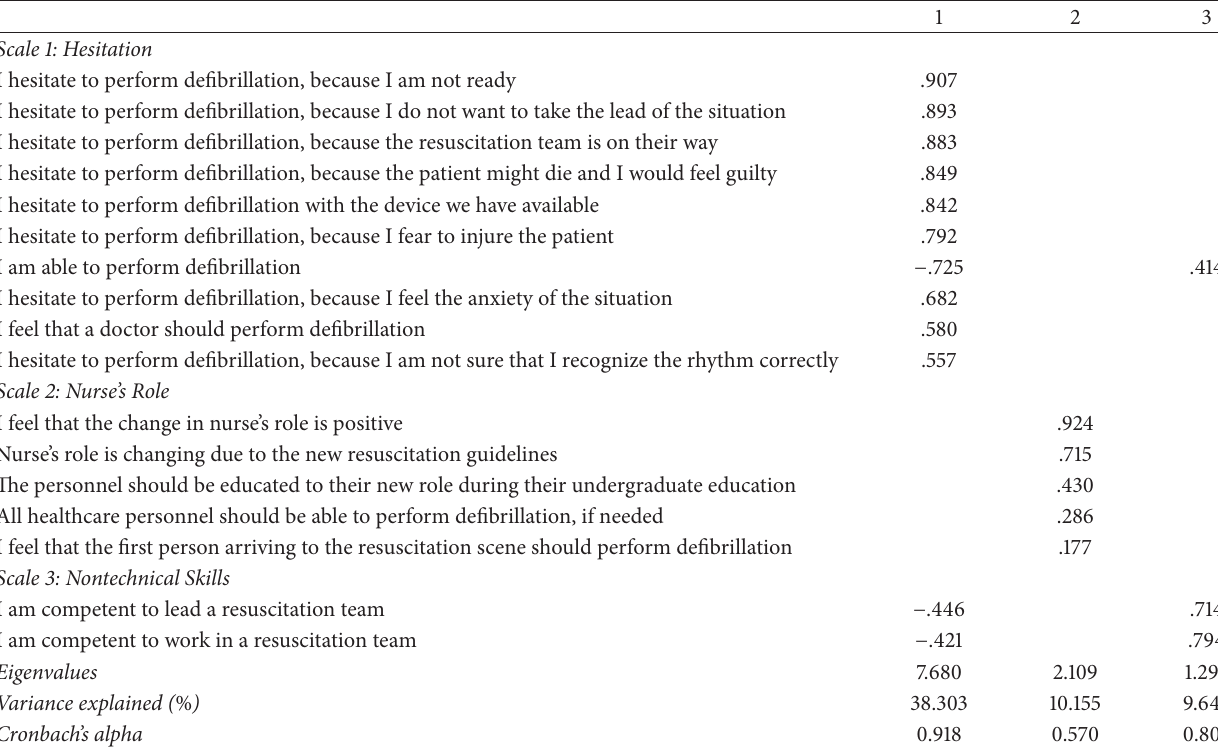
Table 1: Factor loading of the questionnaire distributed to the participants consisting of 58 items using maximum likelihood and varimax rotation. Eigenvalues, total variance explained by factors, and Cronbach’s alphas for scales are presented in the table.